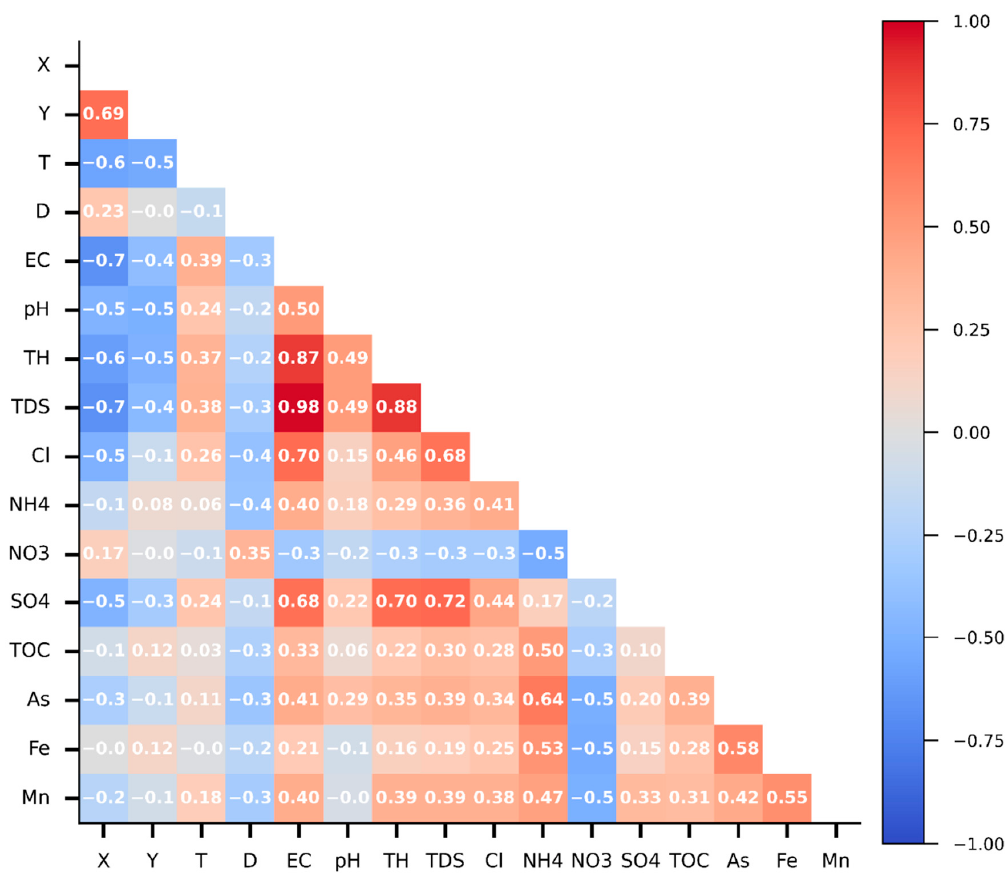
Figure 5. Spearman correlation matrix for all parameters.